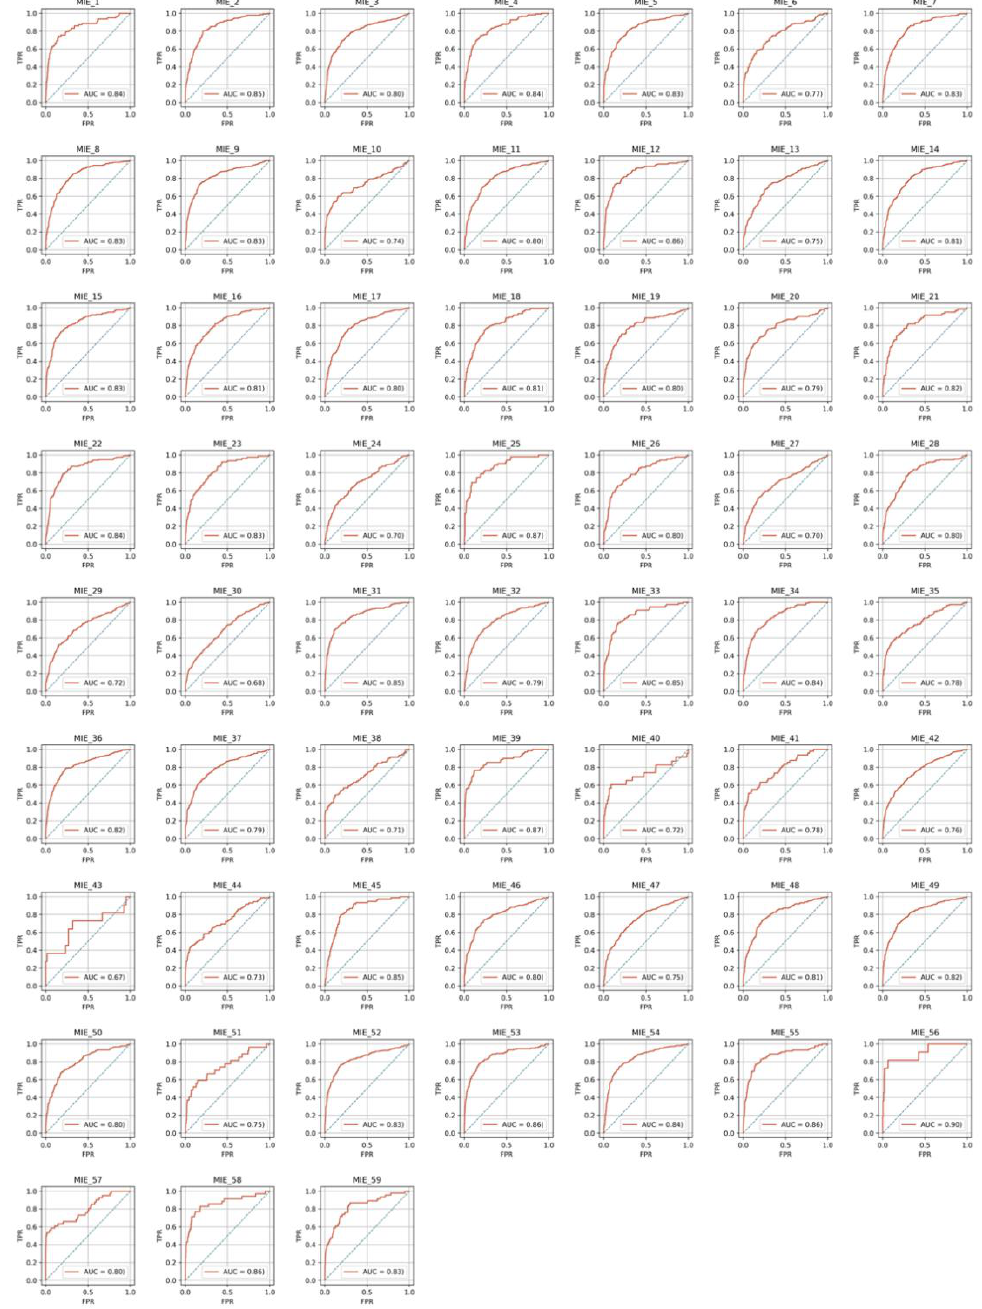
Figure 3. Receiver operating characteristic curves with the test set in the case of criteria 1